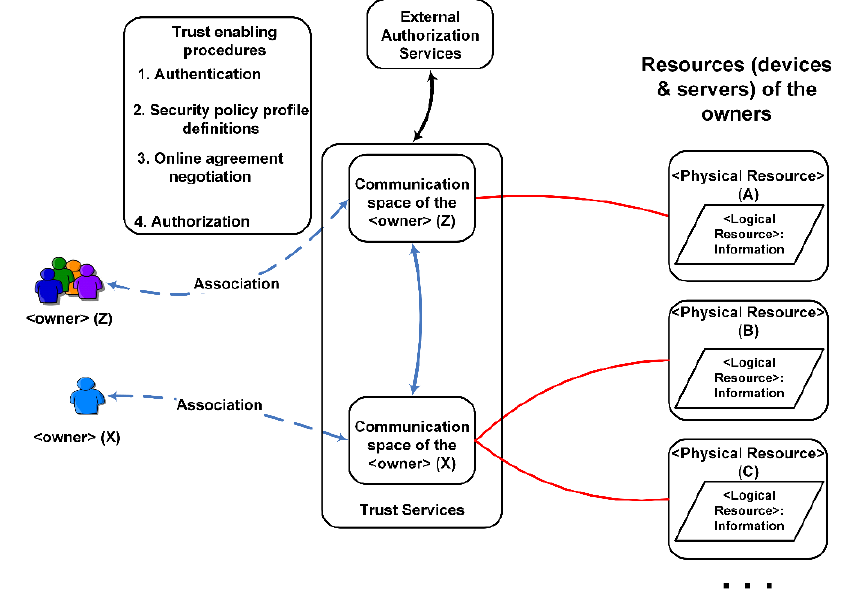
Figure 6. Trust services of CPS hub.